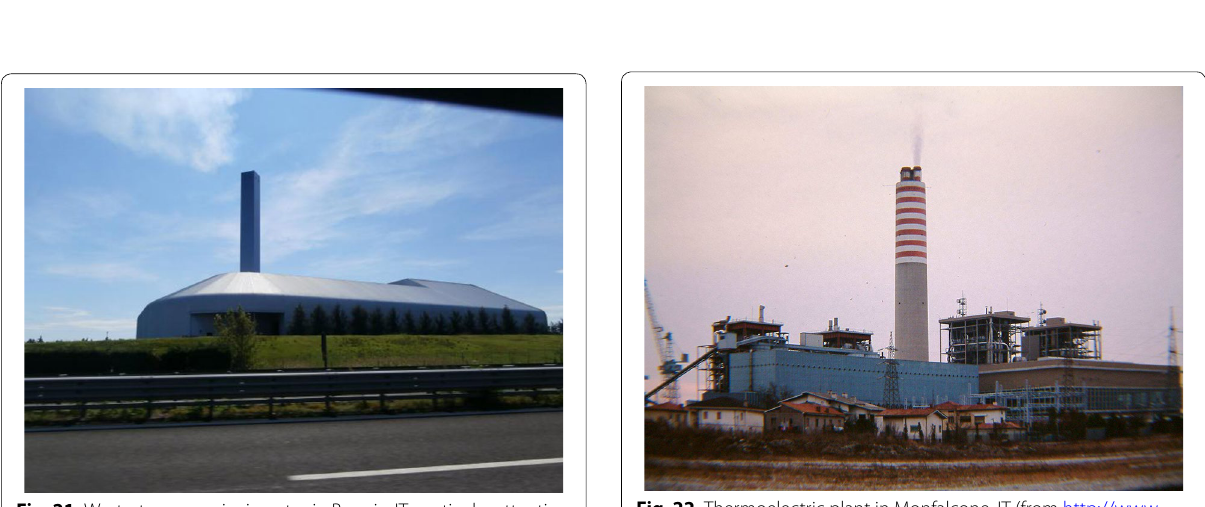
Fig. 21 Waste-to-energy incinerator in Brescia, IT: particular attention to the envelope and chimney (from http://www.a2a.it). To this category also belong all cases of rehabilitation of old plants